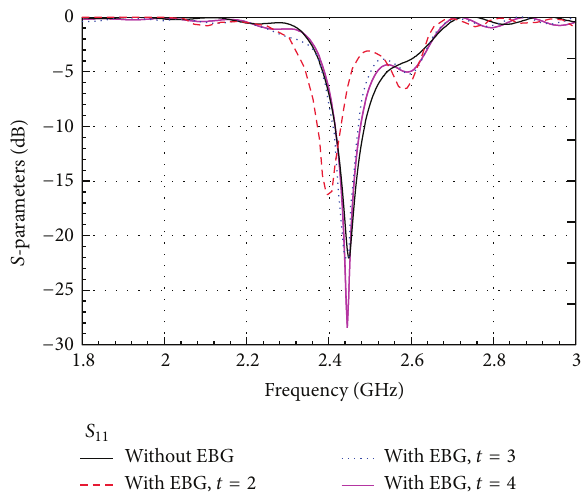
Figure 4: S 11 of switchable surface wave antenna (when t = 2, 3, 4 mm and without